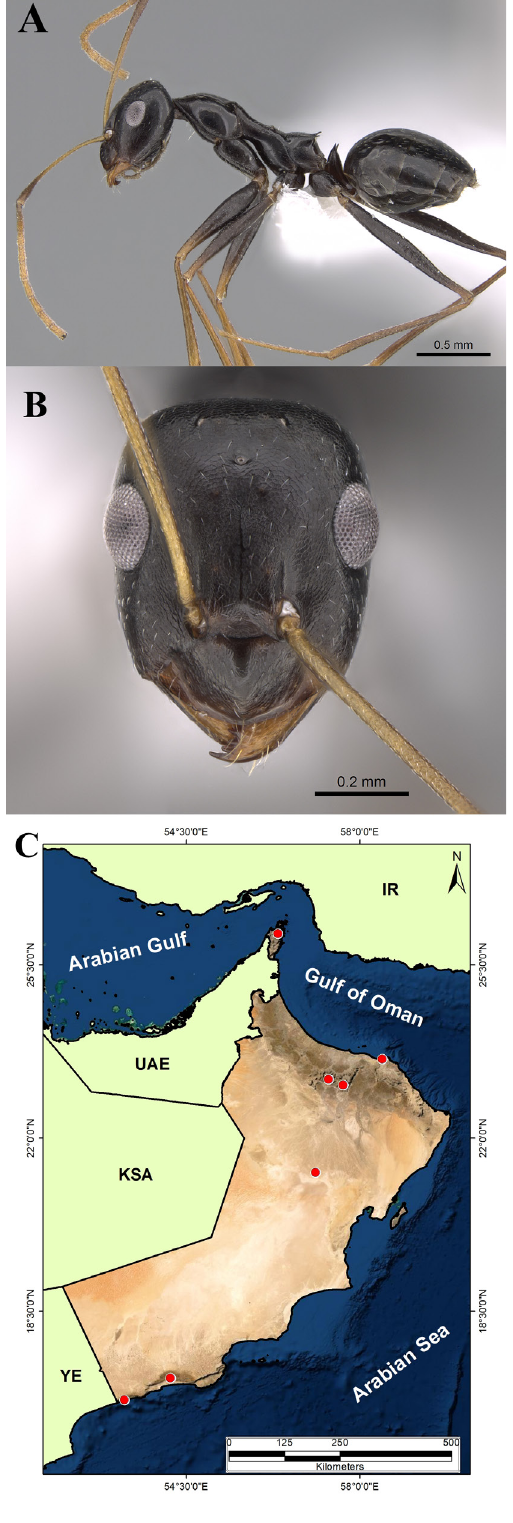
Fig. 21. Lepisiota spinisquama (Kuznetsov-Ugamsky, 1929), worker (CASENT0922842, AntWeb.org (Michele Esposito)). A . Body in profile. B . Head in full-face view. C . Distribution